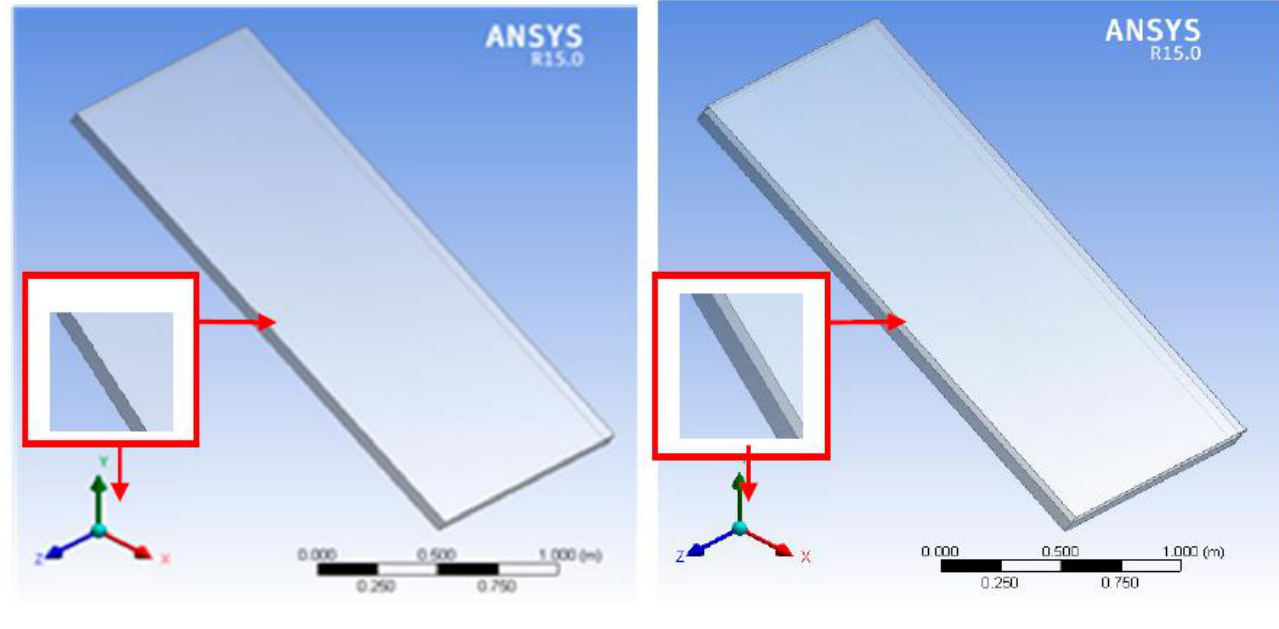
Figure 4. Geometric model for the two tested FPSAHs.